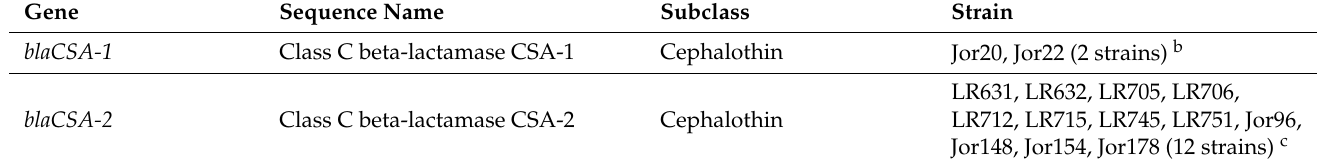
Table 2. Antimicrobial resistance genes identified in plant-associated C. sakazakii genomes a